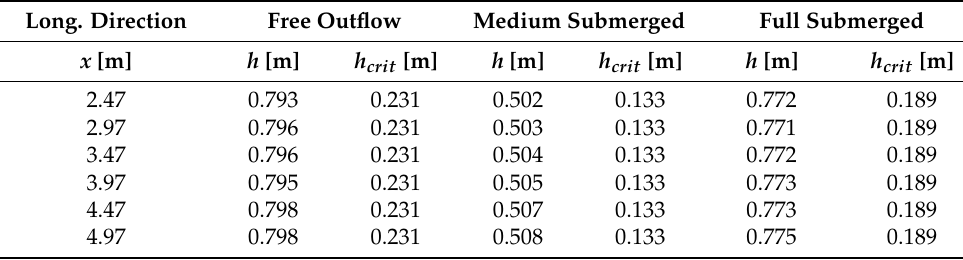
Table A1. Data for flow depth and critical flow depth for the three results from Figure2. Long.